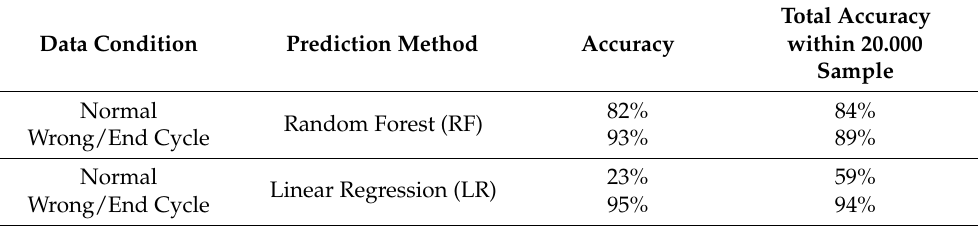
Table 7. Vibration data prediction accuracy for each machine learning method in PdM implementation.